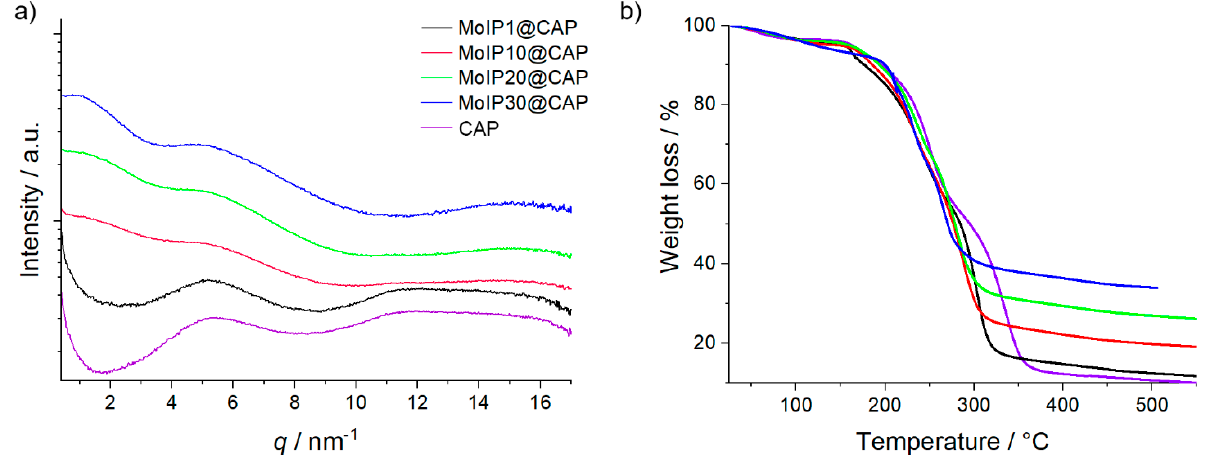
Figure 3. ( a ) Small angle X-ray scattering diffraction patterns at 25 °C. ( b ) Thermogravimetric curves recorded for CAP (purple), MoIP1@CAP (black), MoIP10@CAP (red), MoIP20@CAP (green), and MoIP30@CAP (blue).